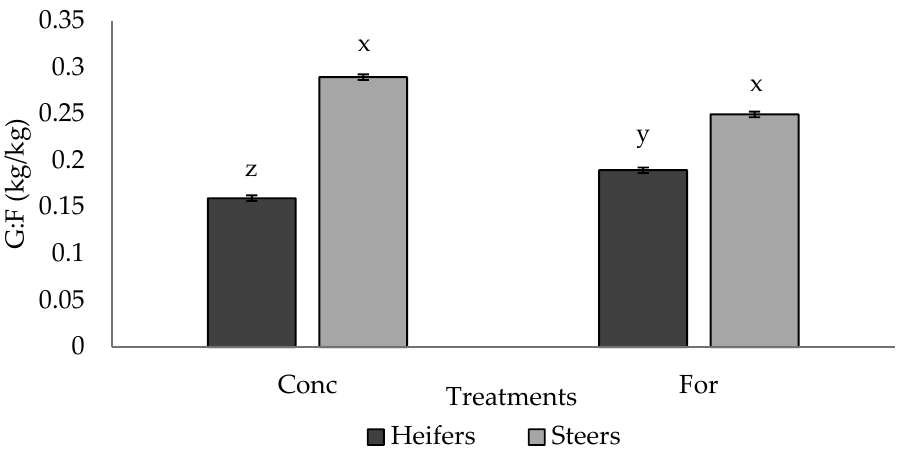
Figure 2. Treatment by sex interaction ( p = 0.065) for G:F (kg/kg) of progeny in Period 2 from dams fed a concentrate-based (Conc) or forage-based (For) diet during mid- and/or late-gestation 1 . 1 Diets formulated based on NRC (2000) requirements for dams fed either a concentrate or forage diet during mid- and late-gestation. x, y, z LSmeans lacking a common superscript differ ( p ≤ 0.05).